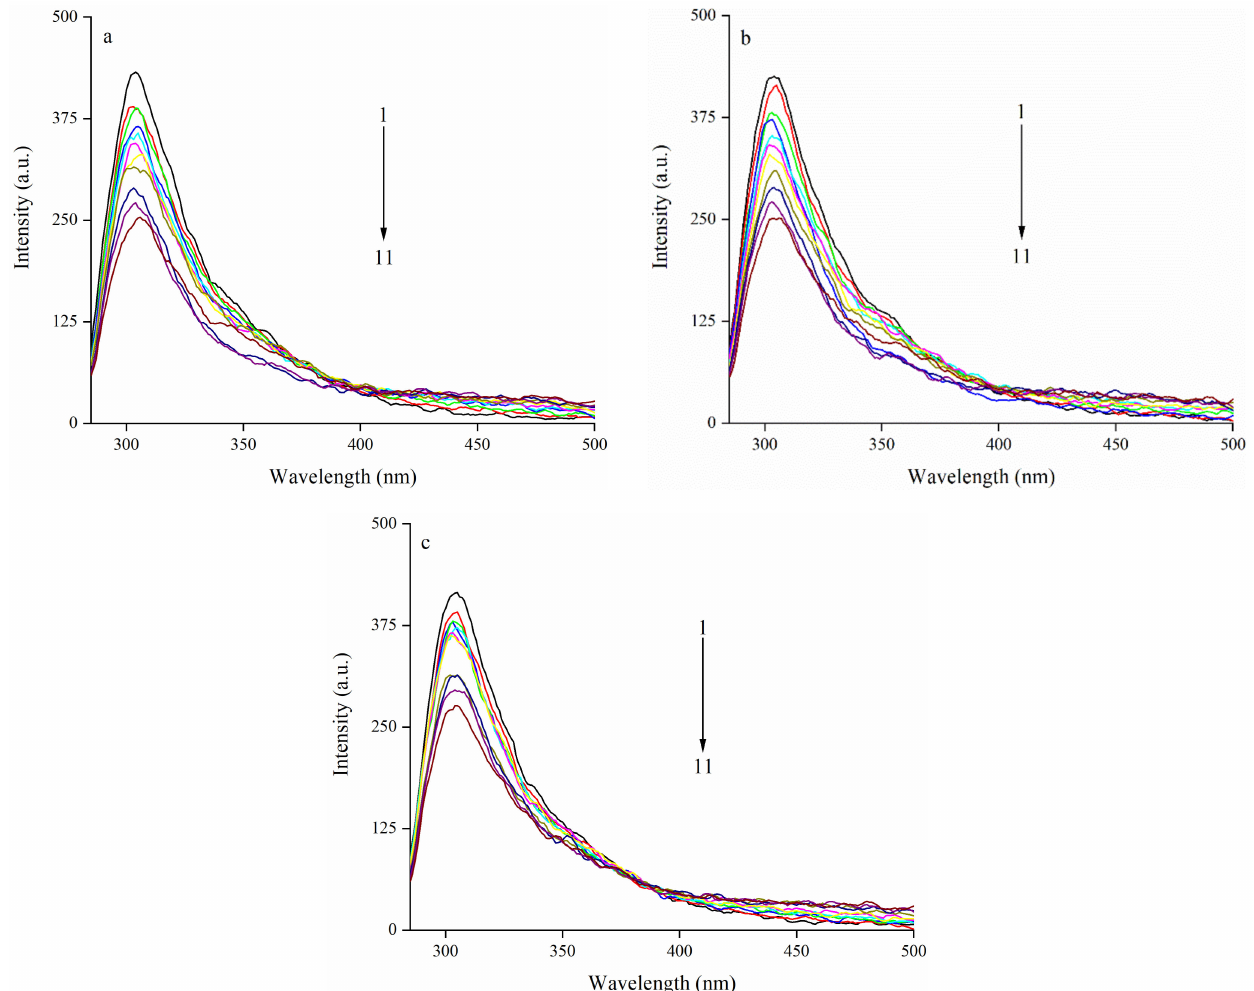
Figure 2. Effect of EA on the fluorescence emission intensity of zein. Note: ( a – c ) represents different treatment temperature for EA and zein; ( a ): 18 ◦ C (291 K); ( b ): 25 ◦ C (298 K); ( c ): 37 ◦ C (310 K); the concentration of zein is 0.05 mg/mL. EA: ellagic acid; curve 1: black curve (0 mg/mL EA); 2: red curve (0.1 mg/mL EA); 3: green curve (0.2 mg/mL EA); 4: blue curve (0.3 mg/mL EA); 5: cyan curve (0.4 mg/mL EA); 6: magenta curve (0.5 mg/mL EA); 7: yellow curve (0.6 mg/mL EA); 8: dark yellow curve (0.7 mg/mL EA); 9: navy curve (0.8 mg/mL EA); 10: purple curve (0.9 mg/mL EA); 11: wine curve (1.0 mg/mL